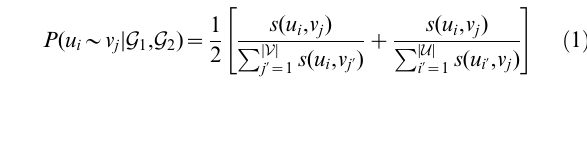
Table 1. Performance of different algorithms for pairwise network